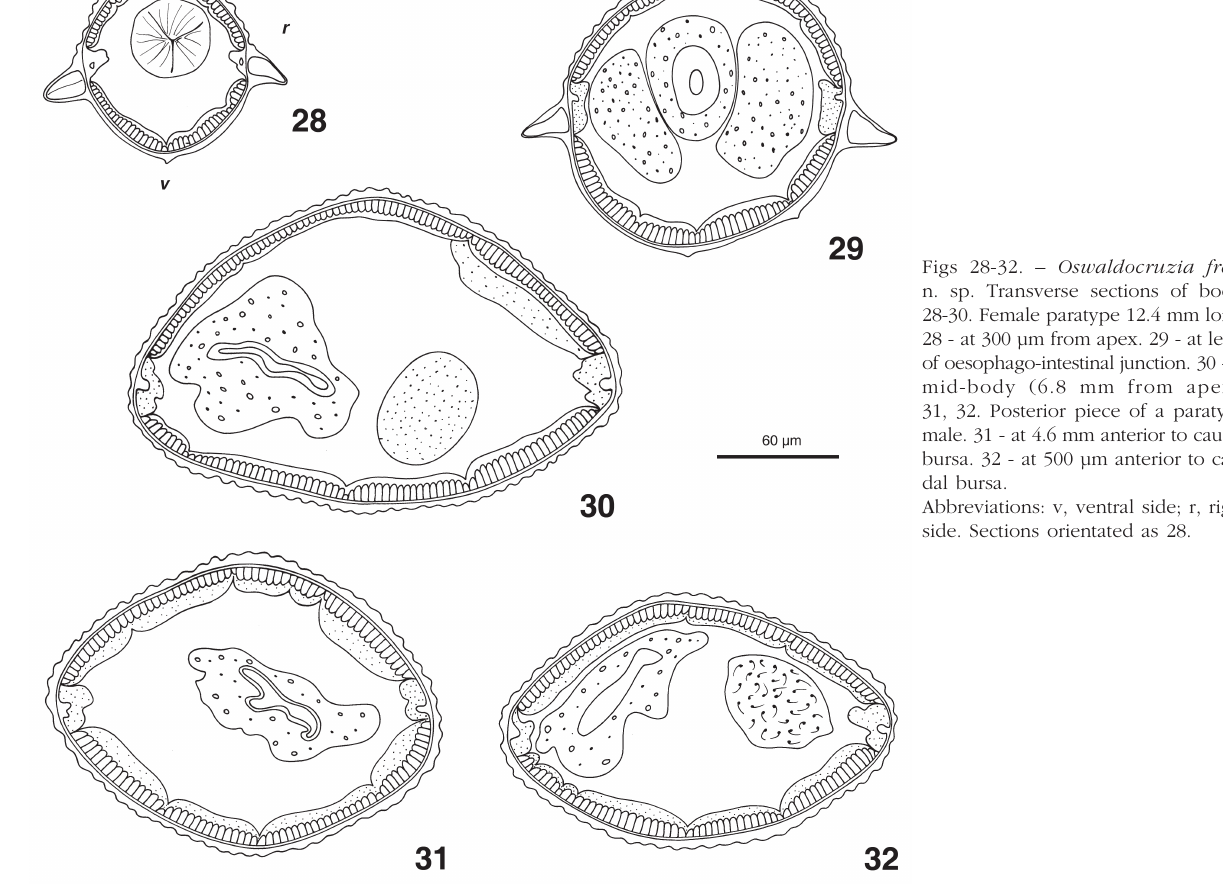
Figs 28-32. – Oswaldocruzia fredi n. sp. Transverse sections of body. 28-30. Female paratype 12.4 mm long. 28 - at 300 µm from apex. 29 - at level of oesophago-intestinal junction. 30 - at mid-body (6.8 mm from apex). 31, 32. Posterior piece of a paratype male. 31 - at 4.6 mm anterior to caudal bursa. 32 - at 500 µm anterior to cau- dal bursa. Abbreviations: v, ventral side; r, right side. Sections orientated as